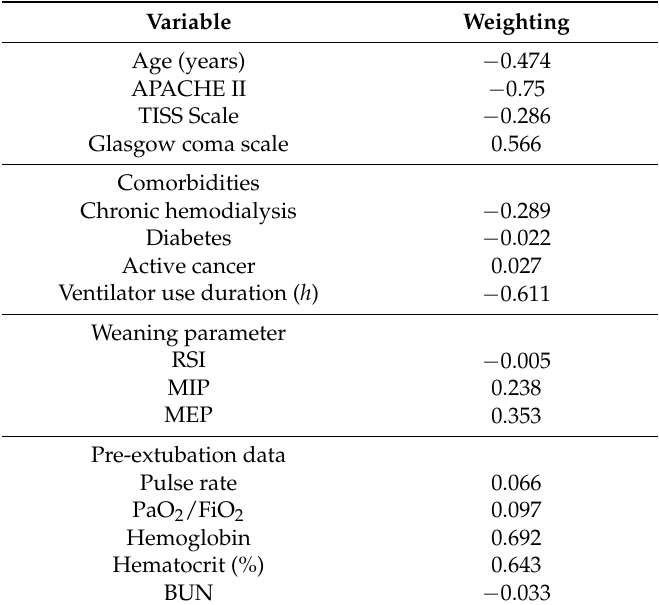
Table 4. Weighing of each variable in the composite score.